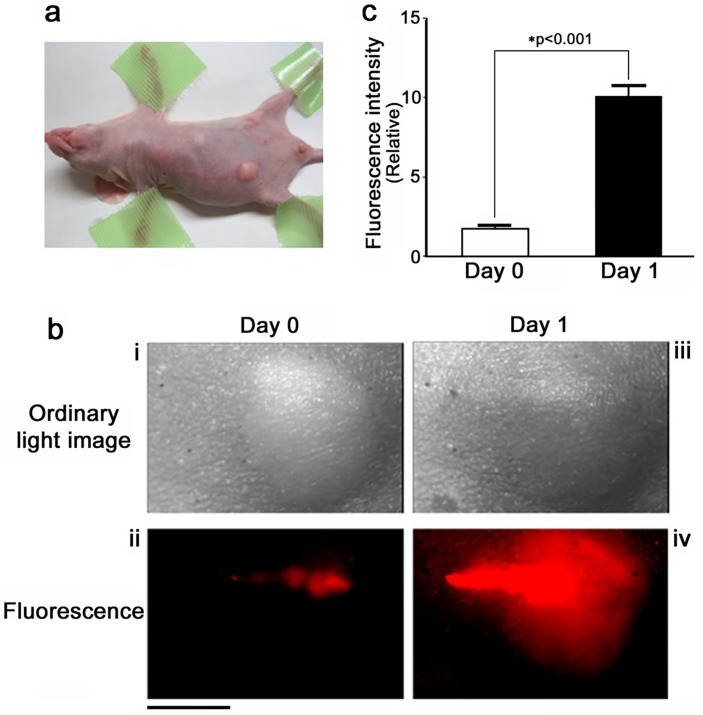
Intratumoral proliferation of KR-E. coli.
a, NPC tumor subcutaneously formed in a nude mouse. b, The distribution of KR-E. coli immediately after intratumoral injection (left), and one day after the injection (right). Scale bar, 5 mm. c, Quantification of the fluorescence intensity of KR-E. coli immediately after the intratumoral injection and one day after the injection (n = 10). *p<0.001 (t-test). Error bars indicate standard error of the mean (SEM). The fluorescence intensity was calculated by summating the digital values of all points in the field of view, and expressed in a relative manner.